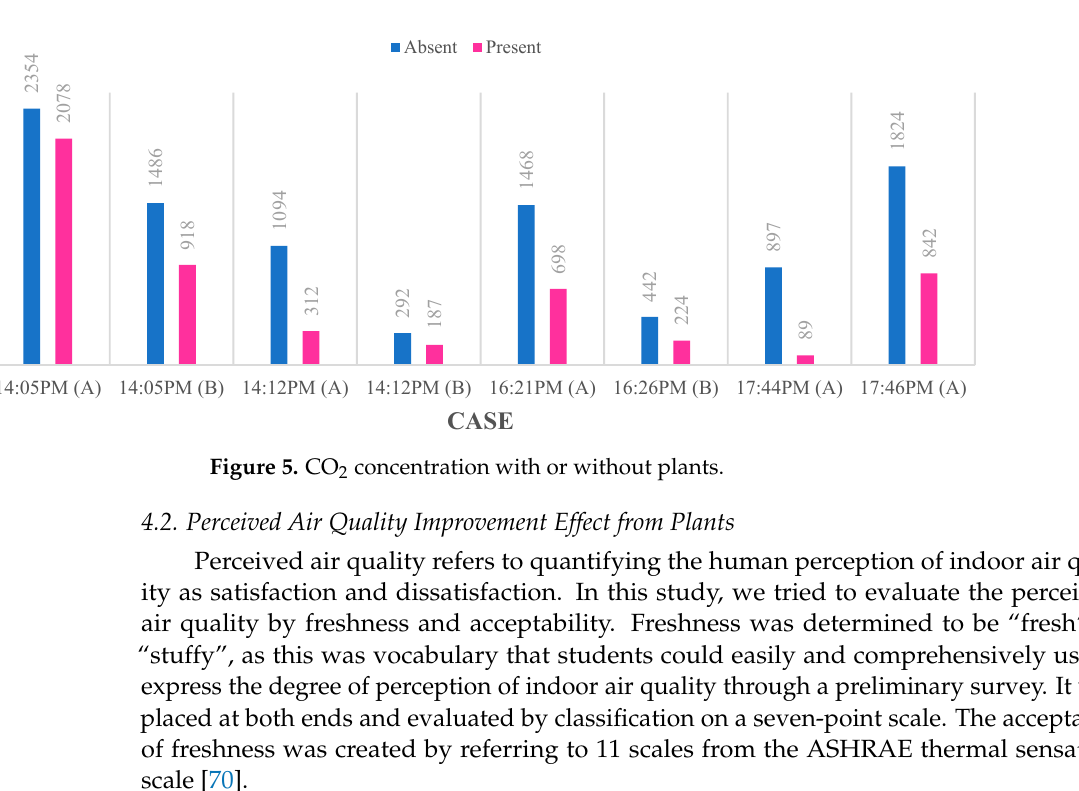
Figure 4. Changes in CO 2 with or without plants.